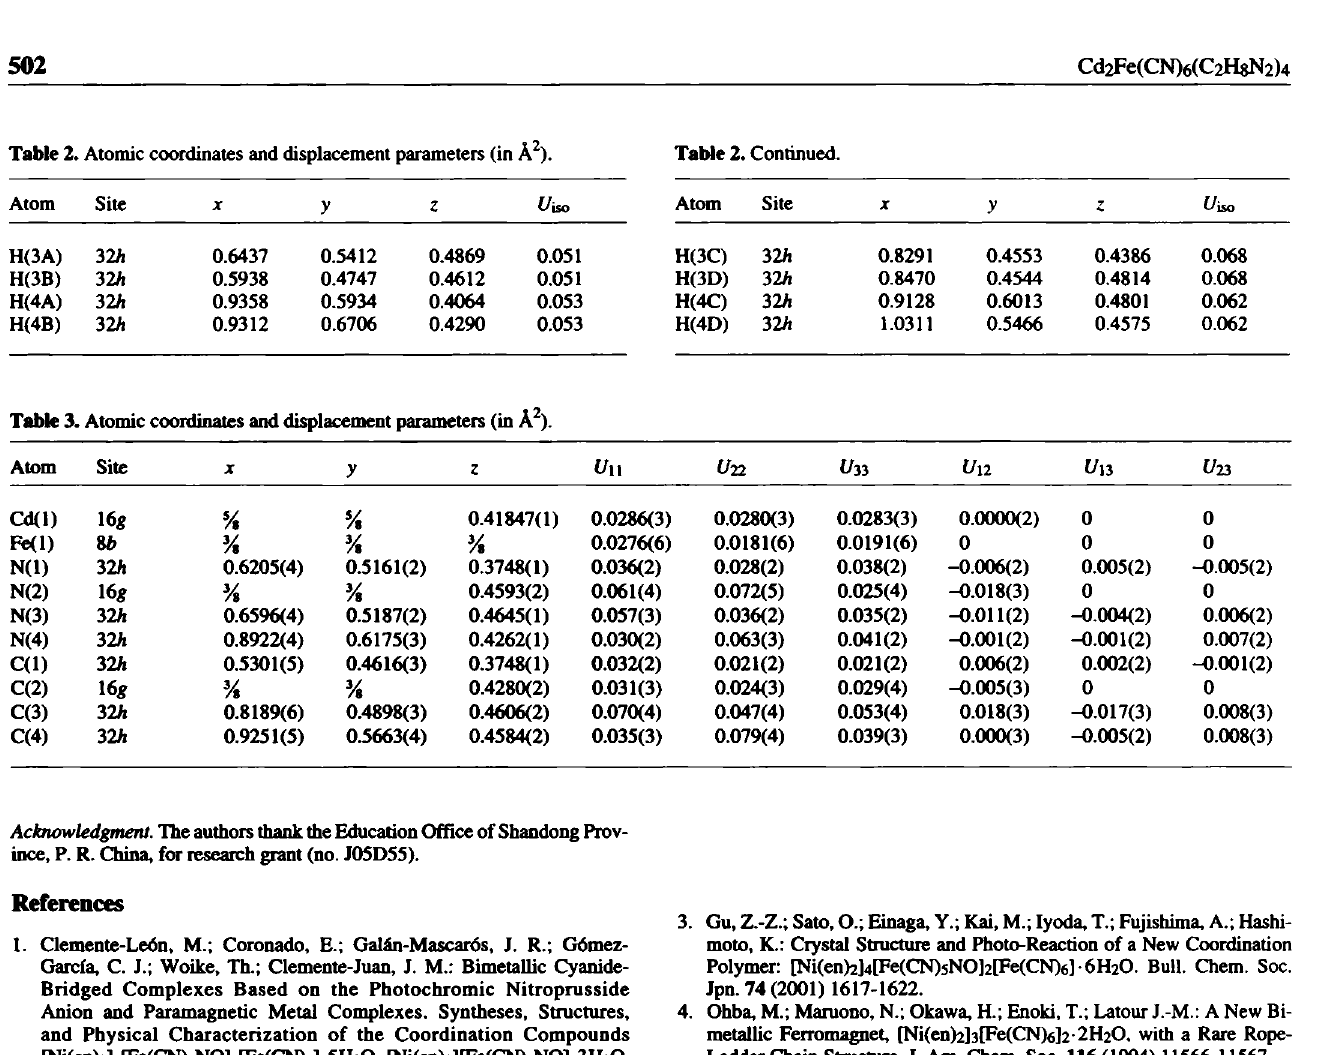
Table 3. Atomic coordinates and displacement parameters (in A 2